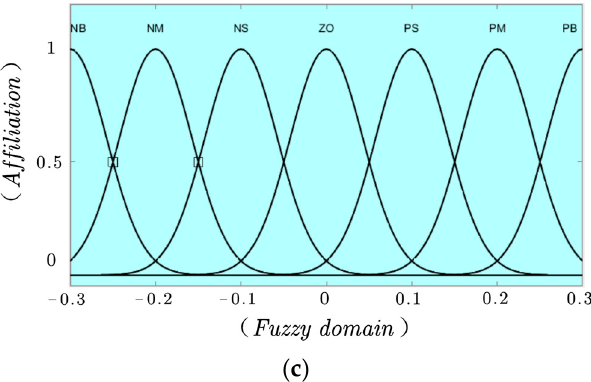
Figure 9. ( a ) The affiliation function and distribution of e and e c ; ( b ) the affiliation function and distribution of ∆ K p ; ( c ) the affiliation function and distribution of ∆ K i and ∆ K d . Table 2. Fuzzy rules of ∆𝐾 (cid:3043) , ∆𝐾 (cid:3036) and ∆𝐾 (cid:3031) .